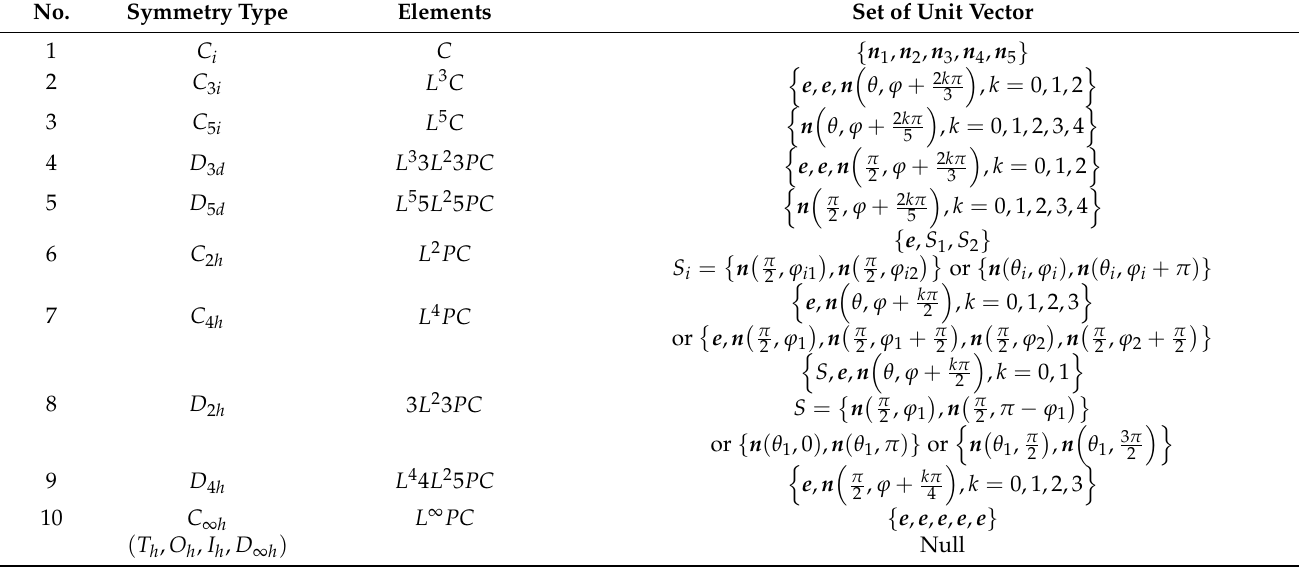
Table 5. Symmetry types and the unit vector sets of (cid:101) H ( 5 )